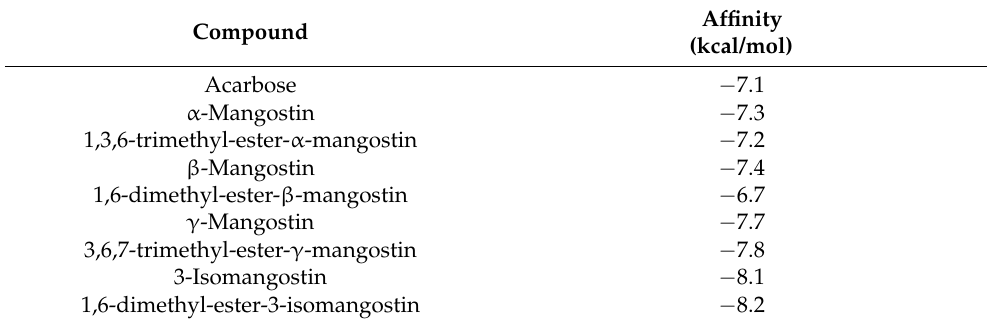
Table 2. Molecular docking results between the α -glucosidase protein and the nine test ligands. Compound